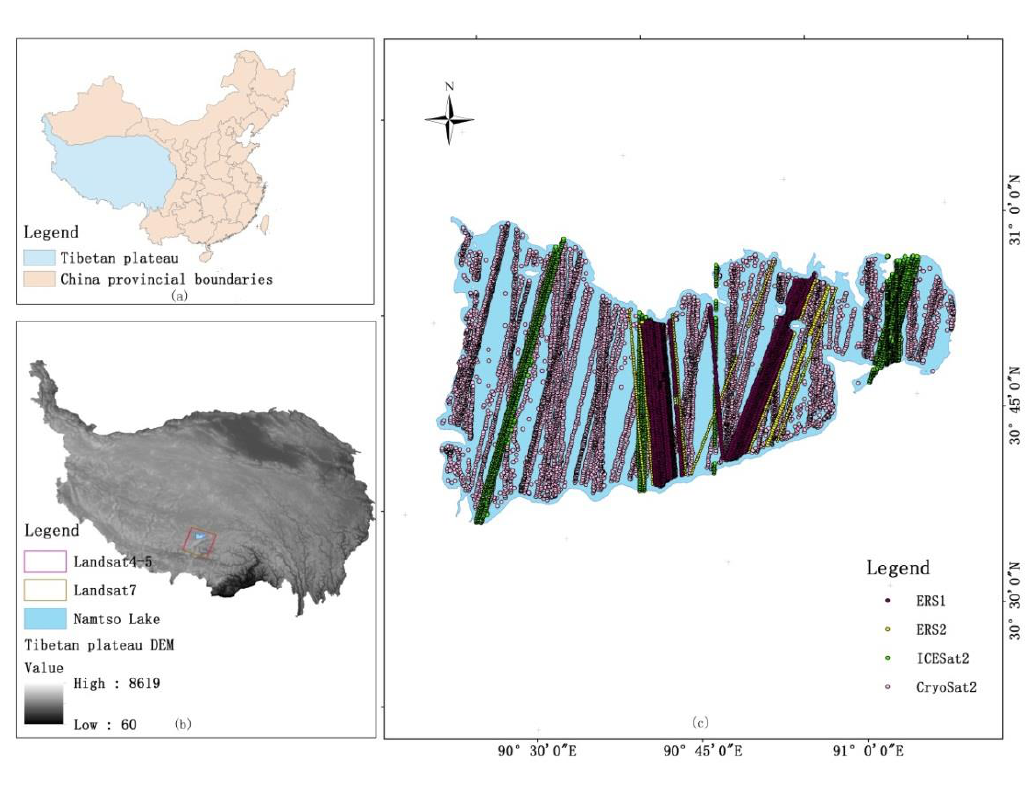
Figure 1. Location of the study area: (a)China map; (b)map of Tibetan Plateau; and (c)map of Nam-Co Lake